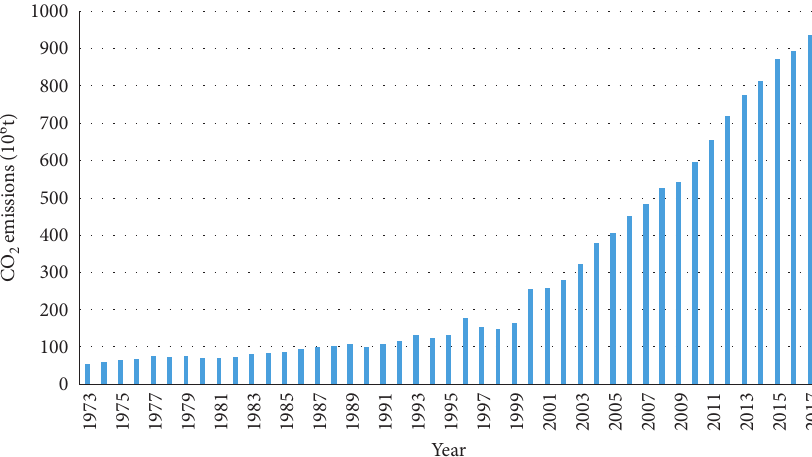
Figure 1: Carbon dioxide emissions from the Chinese transportation industry from 1973 to